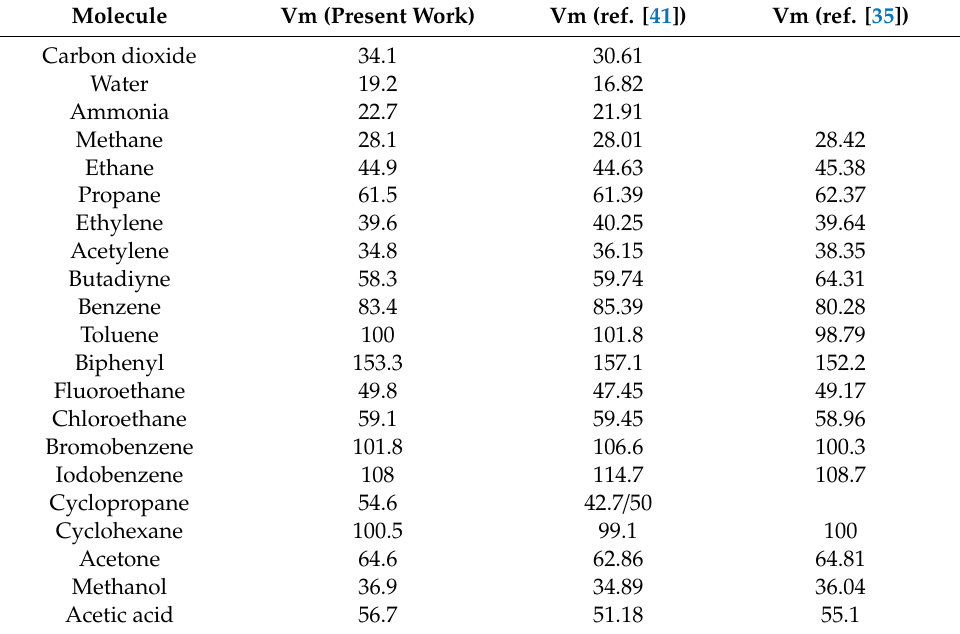
Table 1. Comparison of “true” molecular volumes in A 3 with literature